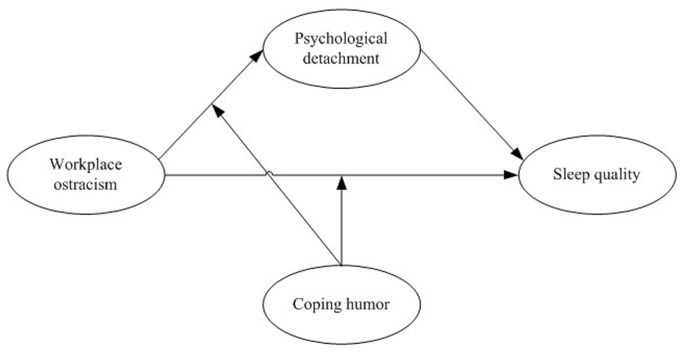
Conceptual model.